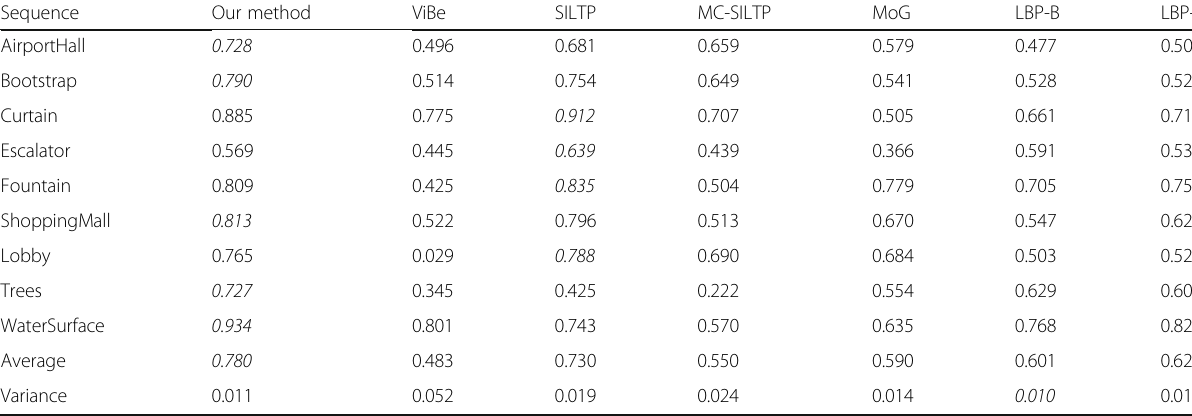
Table 2 F1 results on the Star